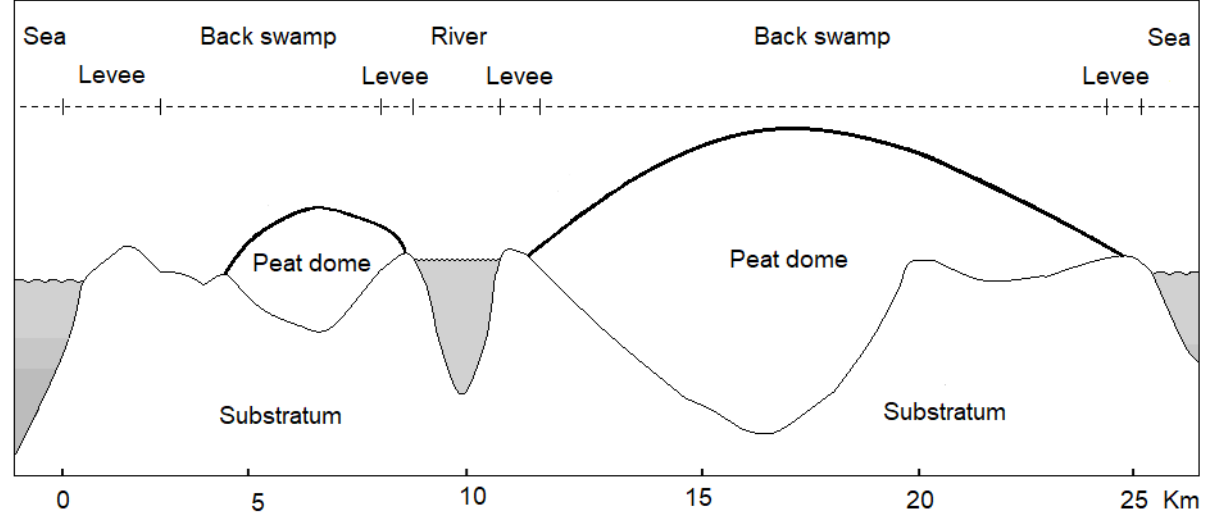
Figure 1. Diagrammatic cross-section of peat swamp morphology on Tebing Tinggi Island, showing the natural sequence of landforms: levées, back swamps and peat